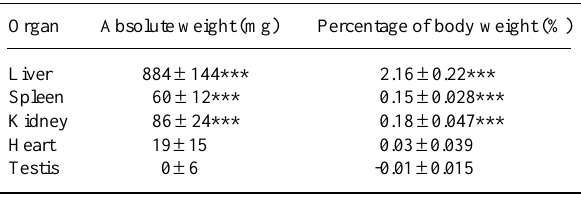
Table IX - Contrast of TC x Z x T with NC x Z organ means ± SE on an absolute weight and percentage of body weight basis a . Organ